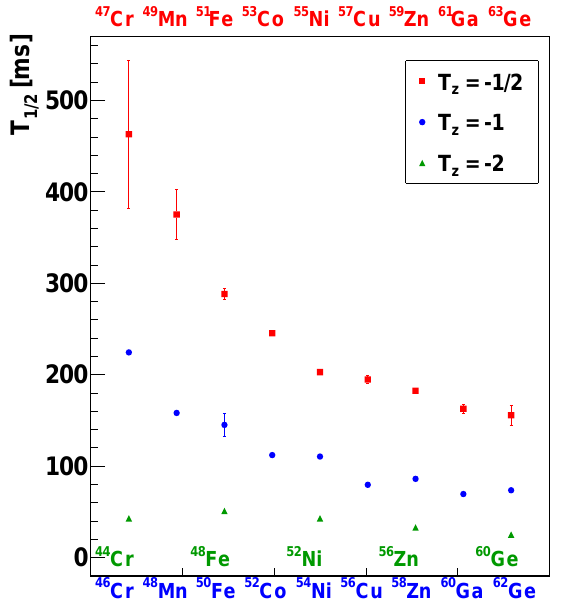
Figure 3. T 1 / 2 values measured for the T z = -1 / 2 (red squares), -1 (blue dots) and -2 (green triangles) nuclei as a function of atomic